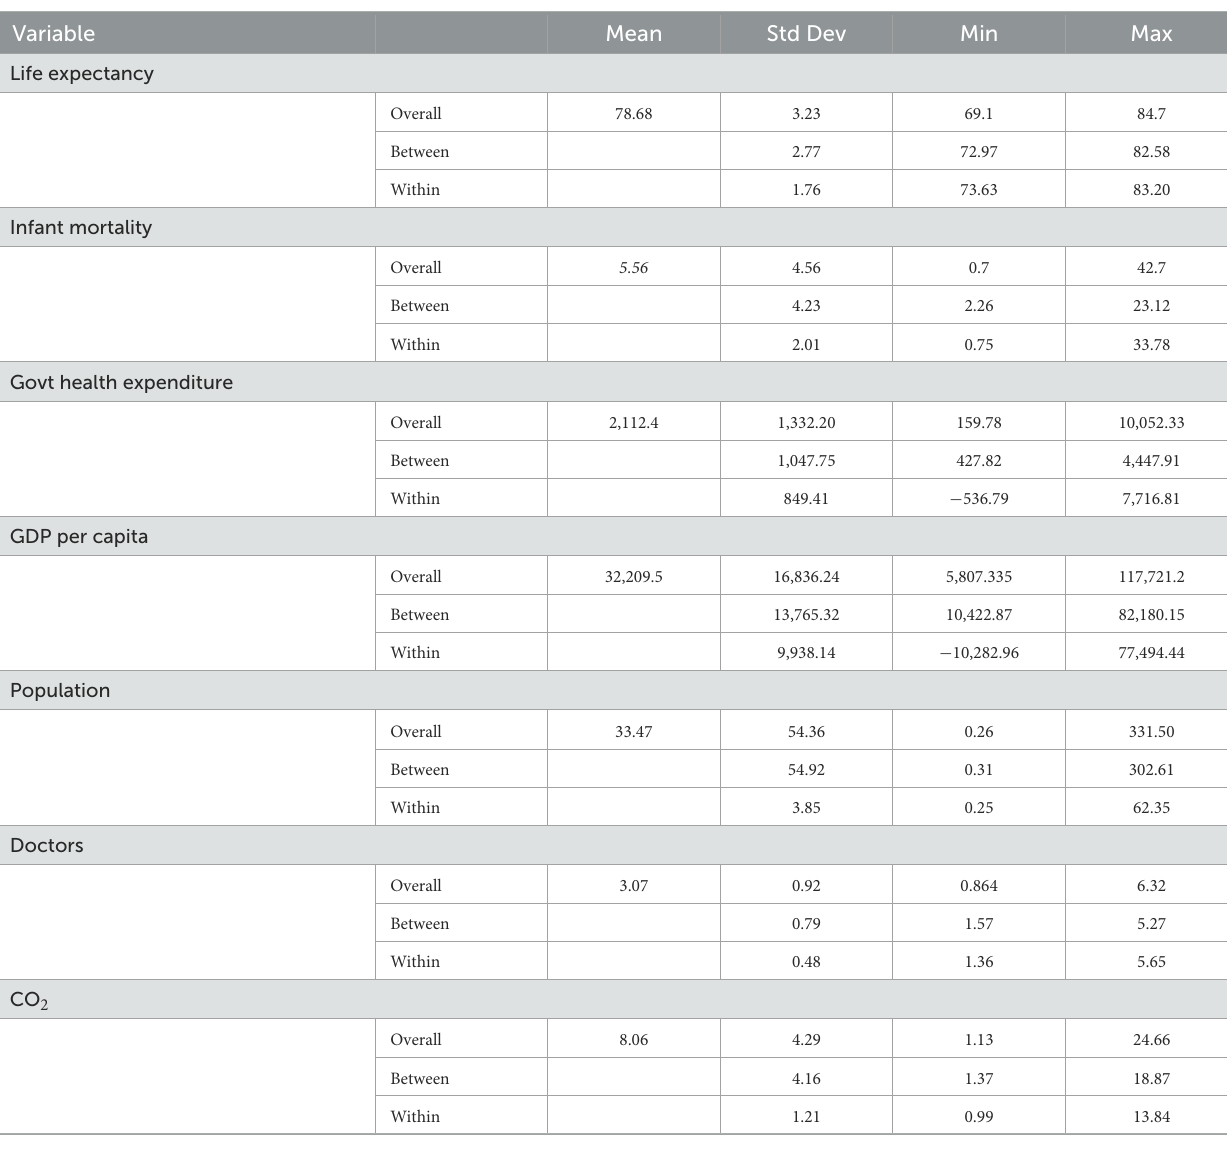
TABLE 1 Descriptive statistics.